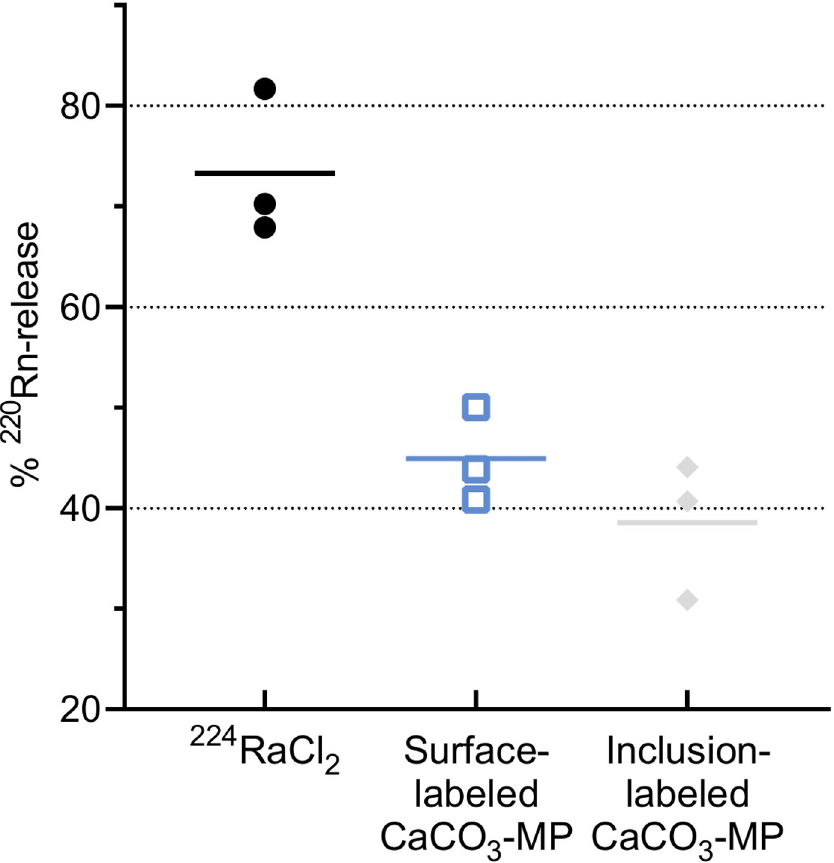
Fig 3. Release of 220 Rn to air from various open 224 Ra microsources. The 220 Rn release was estimated indirectly from measurements of the 212 Pb activity that had re-localized due to 220 Rn diffusion. Each independent sample is indicated with a symbol, and a horizontal line represents the average of these